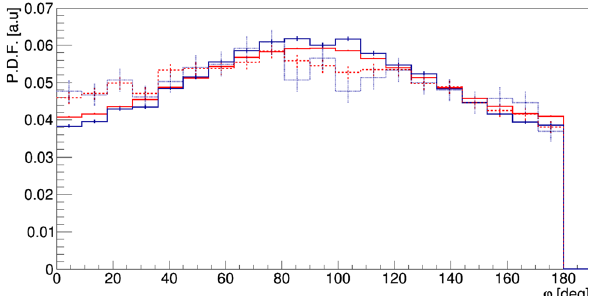
Fig. 13 Distribution of the relative angle ϕ between Compton scatter- ing planes of photons from the p-Ps → 2 γ process for both gammas scatteringsimulatedwiththeGATEpackageadaptedtotheJ-PETdetec- tor. The curves show the solutions for different selection criteria. The black and red solid lines show results obtained for events taken from the region of highest visibility ( θ 1 = θ 2 = 81 . 66 ◦ ) with a radius R = 10 ◦ (black line) and R = 30 ◦ (red line), compare to Fig. 12. The dashed red line represents results for R = 30 ◦ and the selection criterion that a distance between interactions in the scintillators of incoming and outgoing gammas is greater than d > 12 cm. The dotted line includes a further selection criterion that an energy loss in each interaction is larger than 50